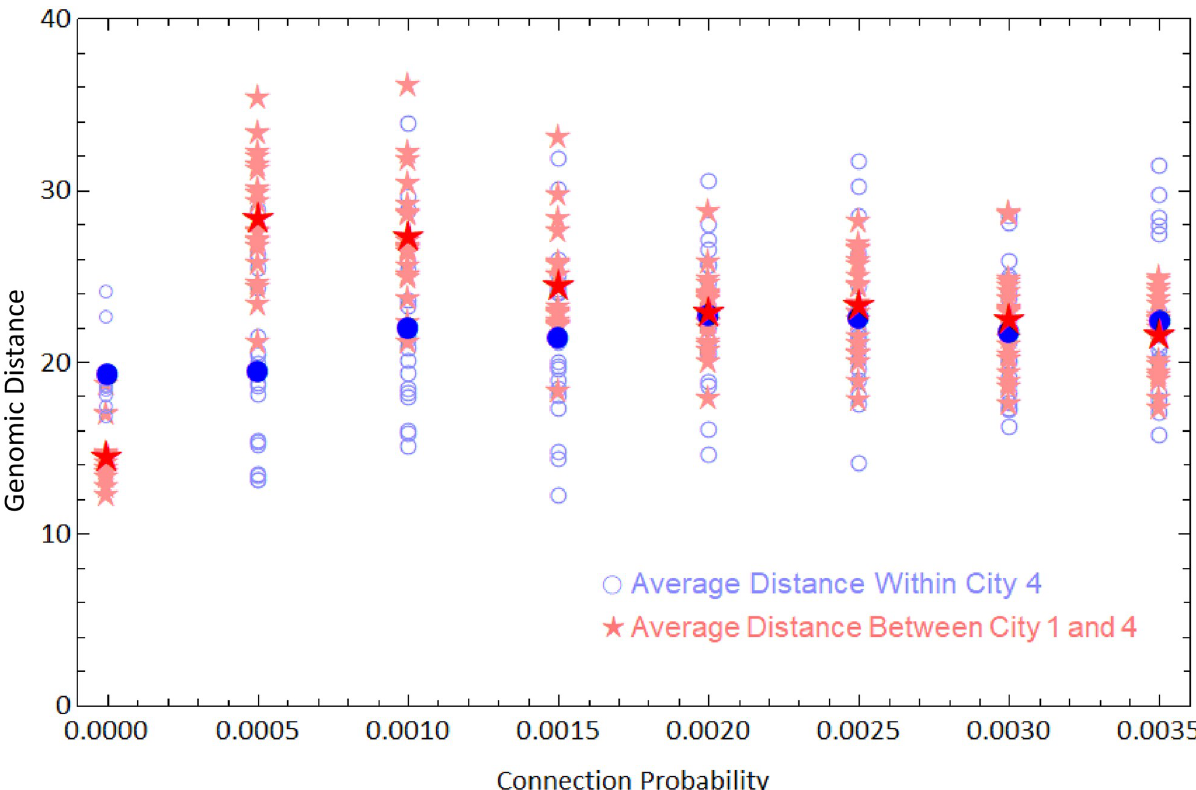
Fig 8. Average genetic distances within cities 1 and 4. Open blue circles are average distance between the viruses of city 4 from a single simulation, and the filled blue circle is average of these values. Light red stars are average distances between viruses from cities 1 and 4 and the dark red star is the average of these values. We ran 20 simulations for each value of connection